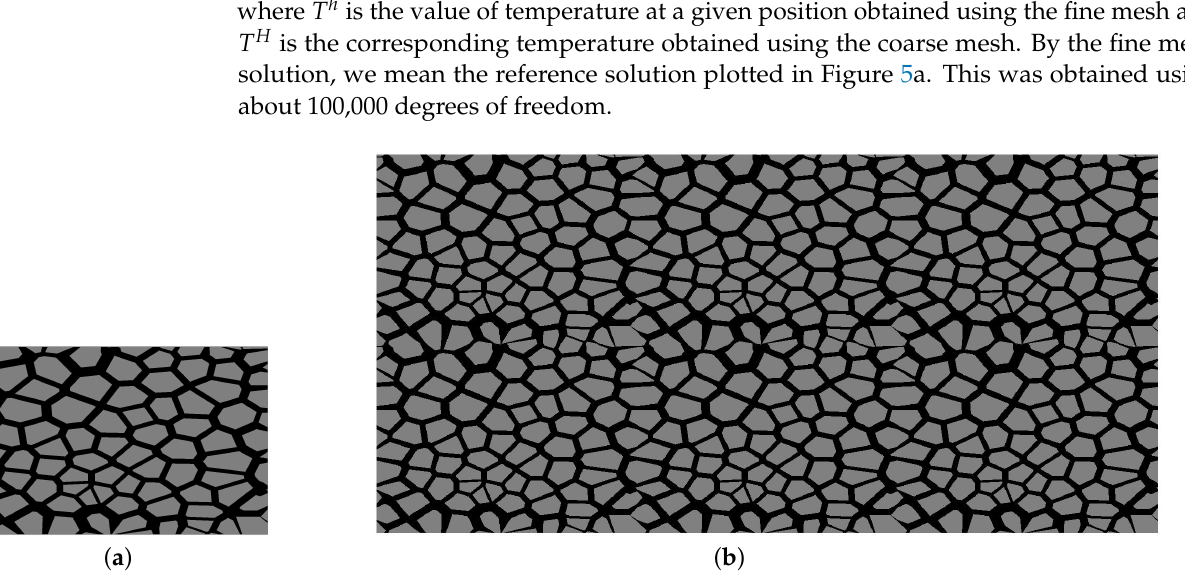
Figure 4. Synthetic asphalt concrete microstructure: ( a ) within a single coarse element, ( b ) within a whole